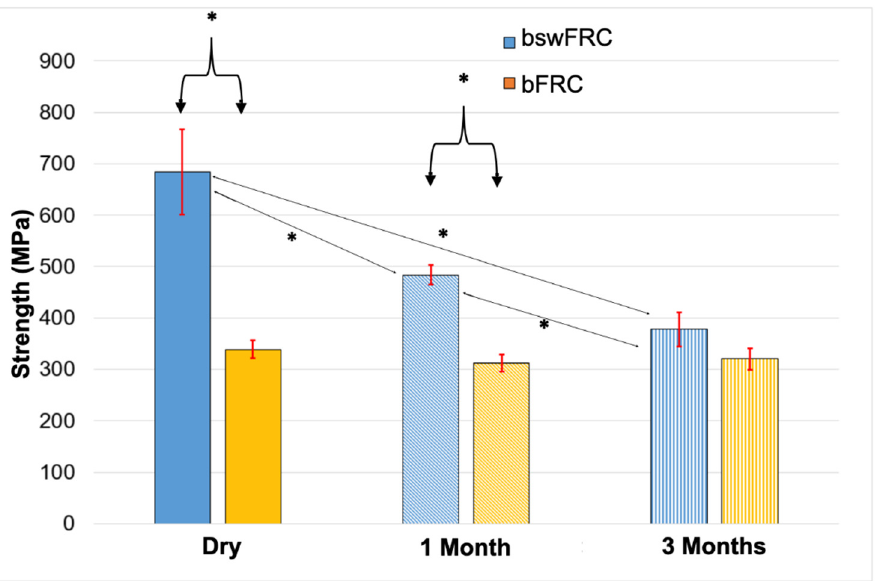
Figure 1. Compressive strength values (mean and standard deviations “MPa”) for bFRC and bswFRC at three aging periods in water at 37 °C (T = 0 “dry conditions”, T = 1 month, T = 3 months). * p < 0.05. Table 1. Evolution of compressive strength (mean ± standard deviations “MPa”) for bFRC and bswFRC in dry conditions, and after immersion in water at 37 ◦ C for 1 month and 3 months. p < 0.05. Group Dry 1 Month 3 Months bFRC 338 ± 19 311 ± 18 321 ± 23 No bswFRC 684 ± 92 484 ± 21 378 ± 36 Yes Statistical analysis ( p < 0.05) Yes Yes